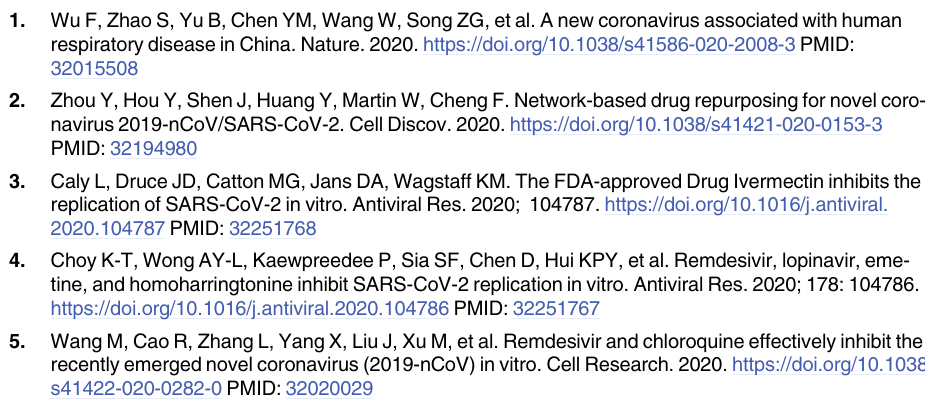
S5 Table. Number of drugs selected after Autodock Vina and DeepBindBC based screening for each Group in S9A